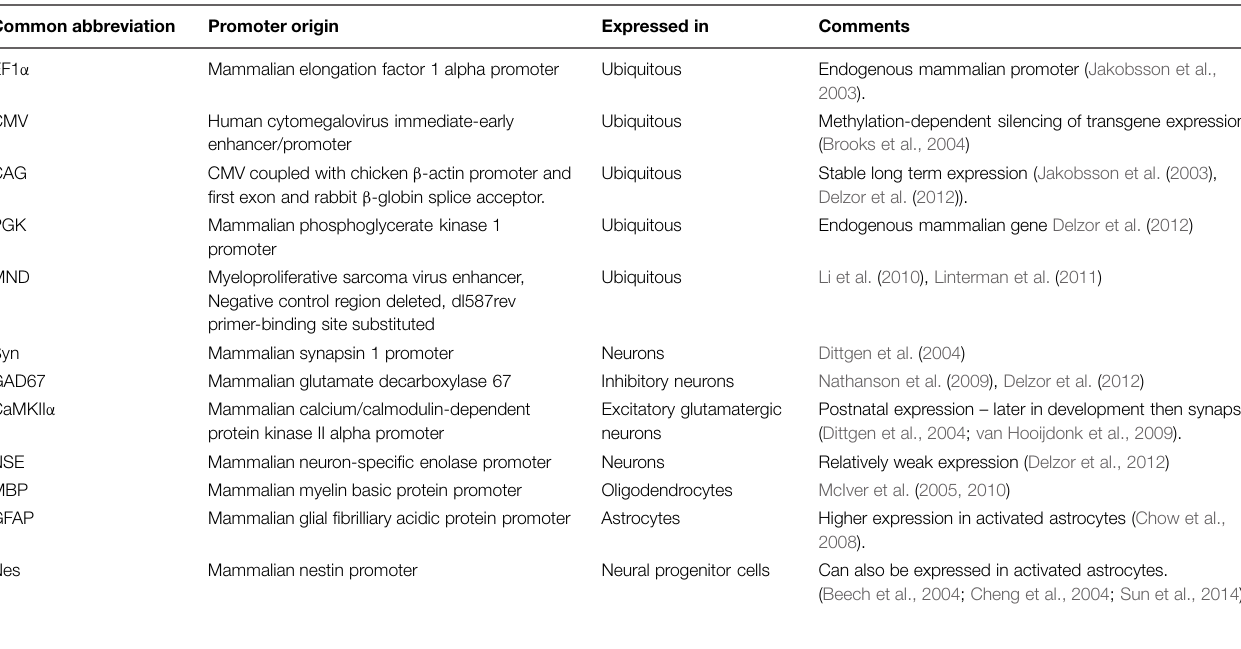
TABLE 1 | Commonly used promoters in